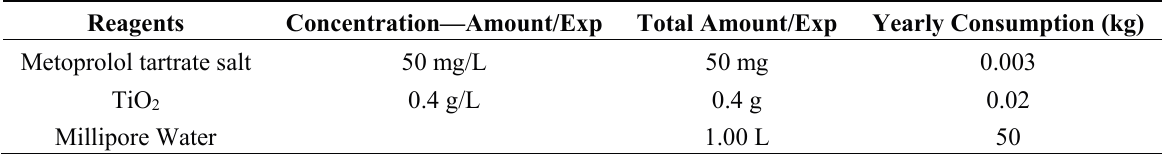
Table 6. Reagent consumption in the photocatalytic experiments with a 1 L reaction volume for 50